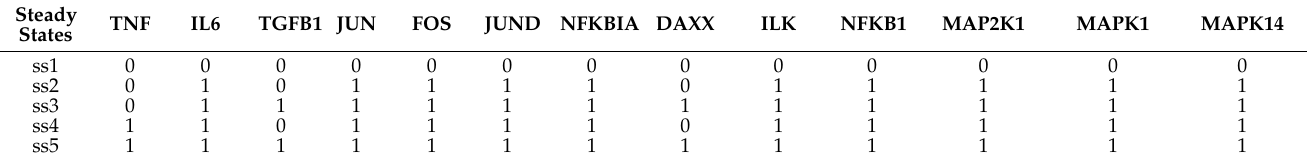
Table 4. Stable states of the Boolean network (wild type).